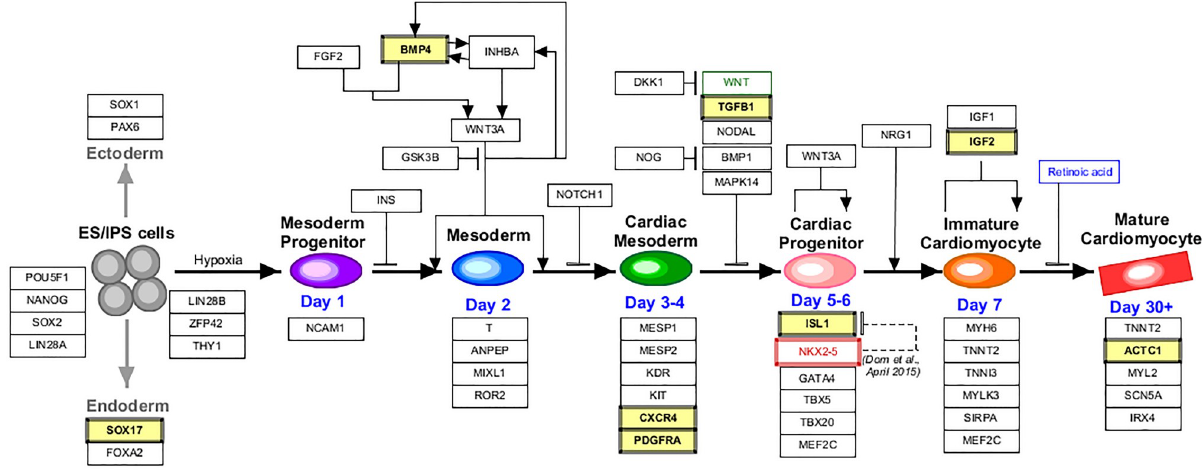
Fig 2. Schematic representation of the cardiac progenitor pathway. Previous studies identified several genetic components related to cardiac development and progression. Genes identified in the present study are shown are highlighted with yellow background.